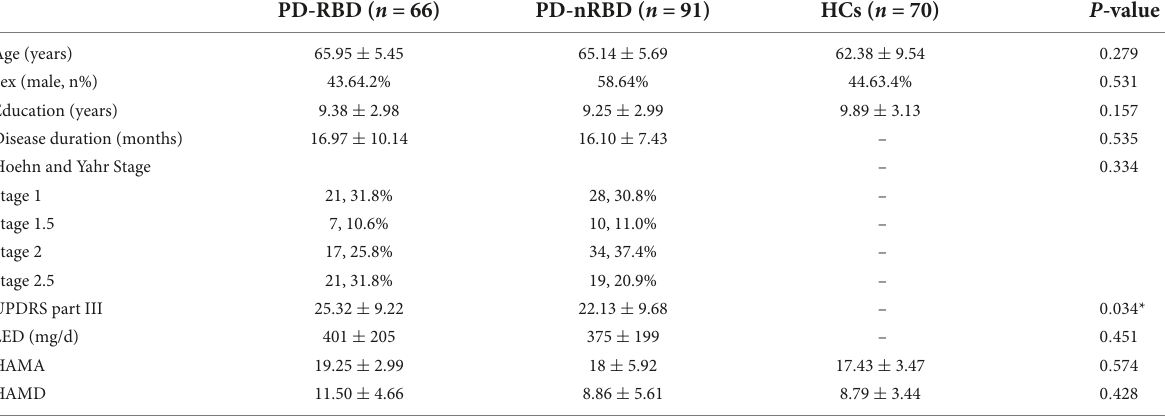
TABLE 1 Baseline demographic and clinical characteristics of PD patients stratified by RBD and Healthy controls.